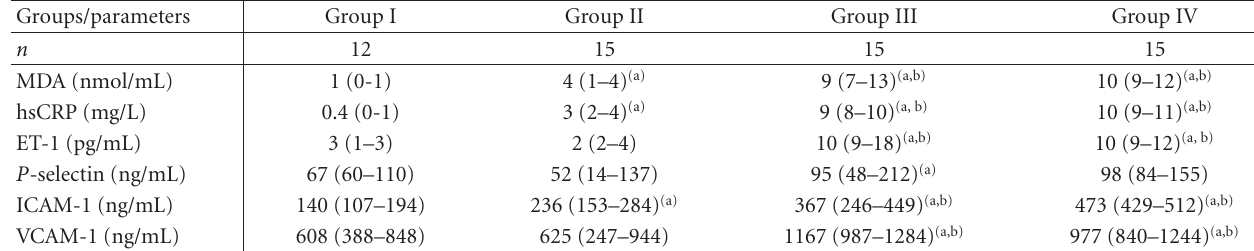
Table 2: Serum concentrations of the studied parameters in healthy controls (group I), ischemic heart disease (group II), type 2 DM who did not perform CABG (group III), and type 2 DM who performed CABG (group IV). Values are median (with the 25th and 75th centiles-